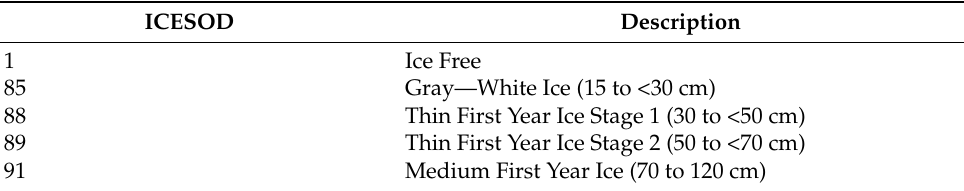
Table 1. BSH Ice chart—Stage of Development